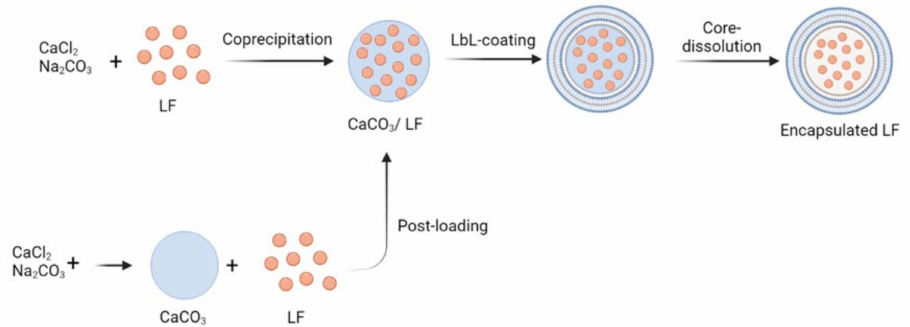
Figure 3. Scheme of LF encapsulation, co-precipitation of CaCO 3 and LF vs. post-loading of LF in porous CaCo 3 mi- croparticles, both followed by Layer-by-Layer (LbL) deposition of bovine serum albumin and tannic acid and final dissolution of CaCO 3 (Redrawn and slightly changed from that contained in the article by Kilic et al. [46], which is an open access article distributed under the terms and conditions of the Creative Commons Attribution (CC BY)